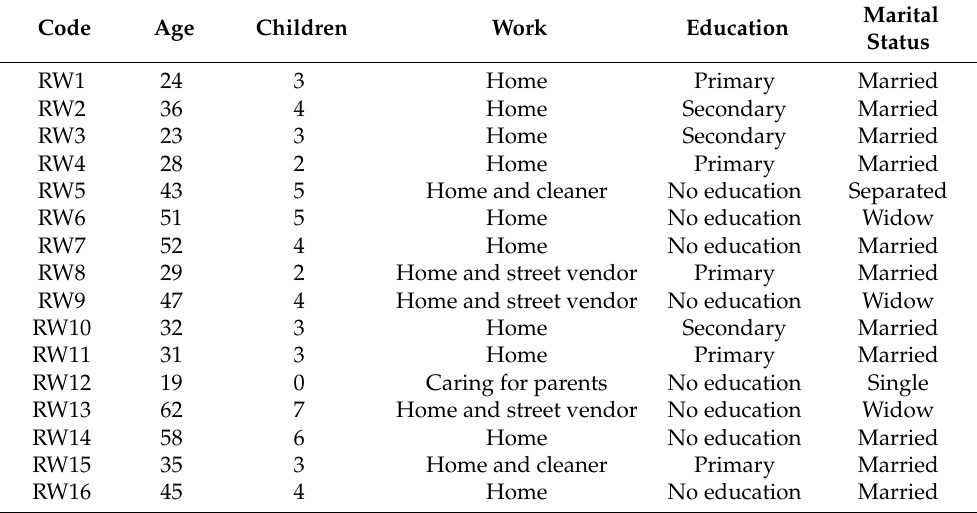
Table 1. Characteristics of the